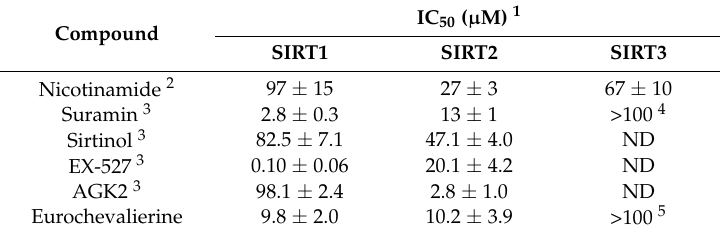
Table 1. In vitro inhibitory activity of selected inhibitors and eurochevalierine on SIRT1, -2, and -3 activities.